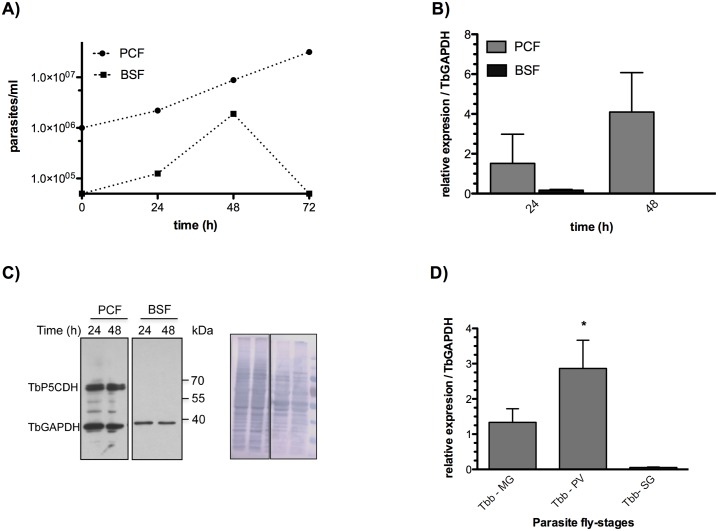
Analysis of TbP5CDH expression levels during the main life stages of T. b. brucei.A) Cell densities from both PCFs and BSFs of T. b. brucei were monitored during 72h of growth. Cell samples were taken at 24h and 48h, and both total-RNA and protein samples were prepared for TbP5CDH expression analysis. B) mRNA expression levels of the TbP5CDH were relative to the expression of TbGAPDH, as housekeeping gene. Bars represent mean +SD from three biological replicates (n = 3). C) Protein levels were analyzed by western blotting using anti-TcP5CDH (1:2,500) and anti-TcGAPDH (1:4,000) diluted in PBS-T plus 5% (w/v) skimmed milk. Protein relative molecular masses were 63 and 39 kDa for TbP5CDH and TbGAPDH, respectively. Protein loading controls were verified by nigrosine staining of the PVDF membrane after probing with specific antibodies. D) The mRNA levels were determined by qPCR using total RNA of T. brucei-infected fly tissues (i). Parasites were isolated from the midgut (MG), proventriculus (PV) and salivary glands (SG). Comparisons were made individually and differences were analyzed using two-way ANOVA and Tukey’s post-test. The asterisk (*) denotes the significance gene expression value (p<0.05) of PV over SG samples.